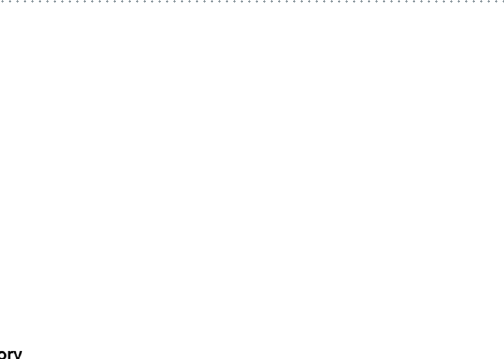
Figure 3. Examples showing variation in the probability of being infected with M. bovis at the time of last capture for a selected sample of badgers, given each individual’s history of capture and test results. The probability of a badger being truly infected varied with its sex, capture history and current and historical diagnostic test results. From July 2006 to October 2013 there were 28 time steps (seasons) when trapping and sampling of badgers occurred. A set of three diagnostic test results appears on a badger’s timeline if it was captured and tested at that time step. Hence badger 015P (top row) was caught and sampled 19 times during the study and on every one of these occasions it tested negative on all three tests. Our model estimated that the probability of it being truly infected at the time of its last capture in 2013 was 0.006 (indicating that despite consistently testing negative over a long time period, the insensitivity of the testing regime and the background prevalence of infection in the population meant this badger nevertheless had about a one in 170 chance of being infected). At the other end of the scale, high probabilities of infection can result from a single positive result if that test has very high specificity (e.g., badger 044 K, which tested positive for M. bovis using the highly-specific culture test) or from repeated positive results to less specific tests (e.g., badger 014N). The probabilities shown were estimated using a multi-state capture-recapture model described in the main text.